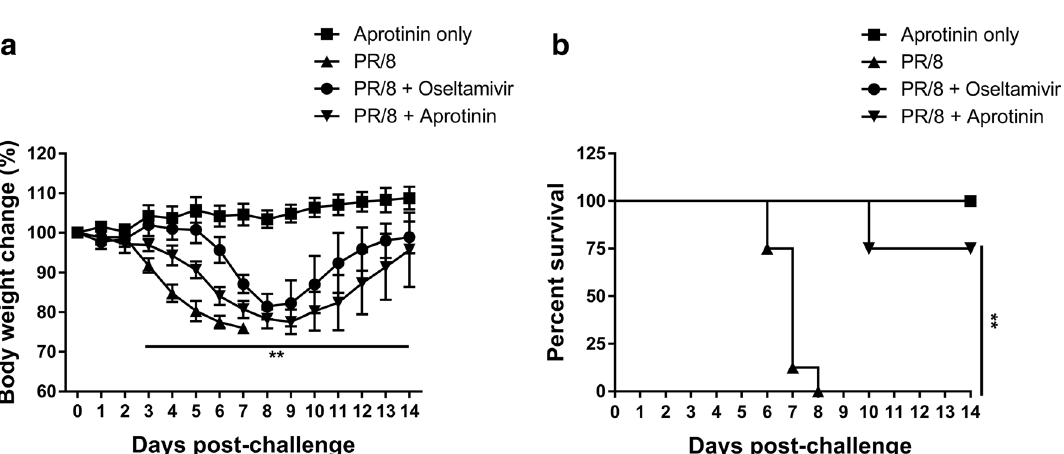
Figure 5. Antiviral effects of aprotinin against influenza A virus in C57BL/6 mice. Groups of mice (n = 8 per group) were intranasally infected with A/PR/8/34 (H1N1) virus at three times the 50% mouse lethal dose (3 LD 50 ). Oseltamivir was orally administered (oral gavage) at 10 mg/kg/day, and aprotinin was intravenously administered at 2 mg/kg, twice daily, for 5 days. Mouse ( a ) body weight changes and ( b ) survival were monitored daily for 2 weeks. ** P < 0.01, significant difference between the negative control group (virus-infected only, PR/8) and the aprotinin treatment group (PR/8 +